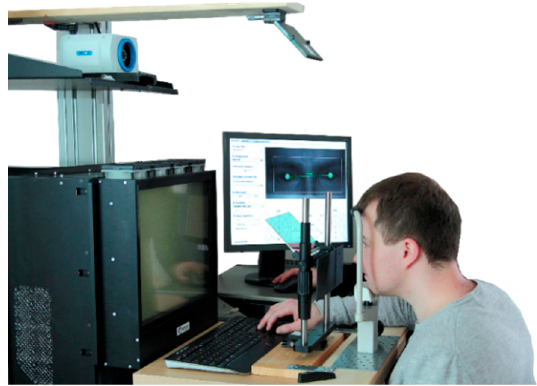
Figure 1. Setup of volumetric display and PowerRef 3 system.